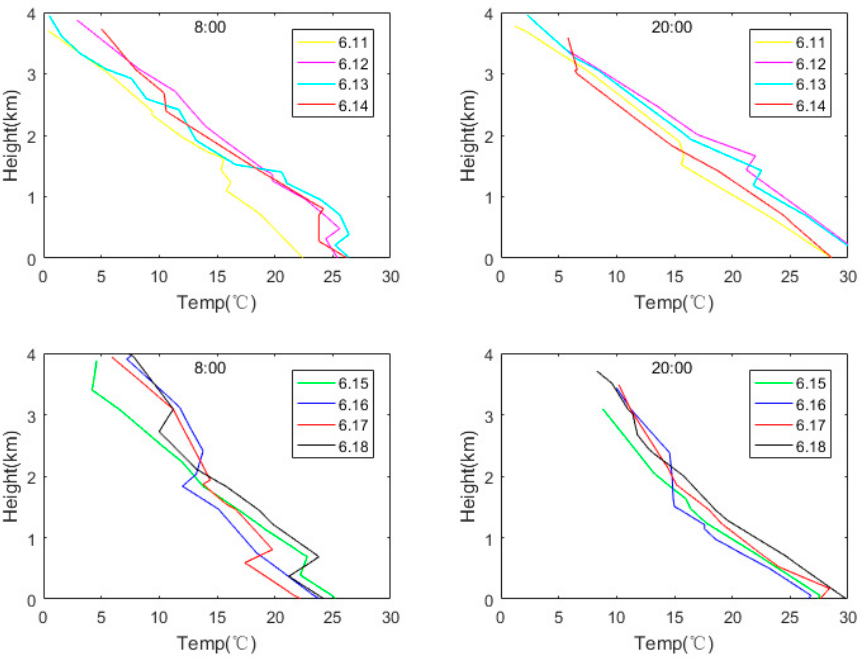
Figure 12. Nanjing station upper air sounding temperature stratification curves, for 08:00 and 20:00, on June 11–18.